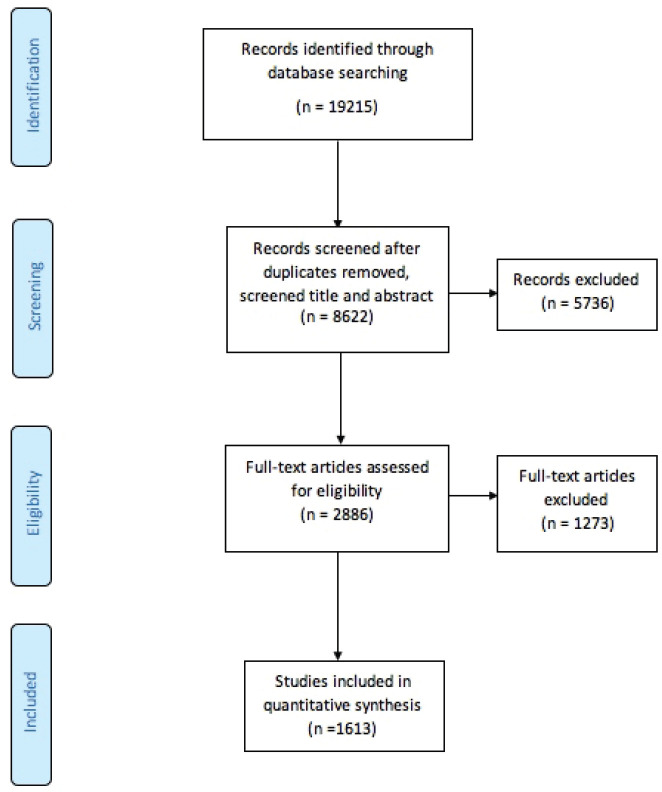
Study flow chart.